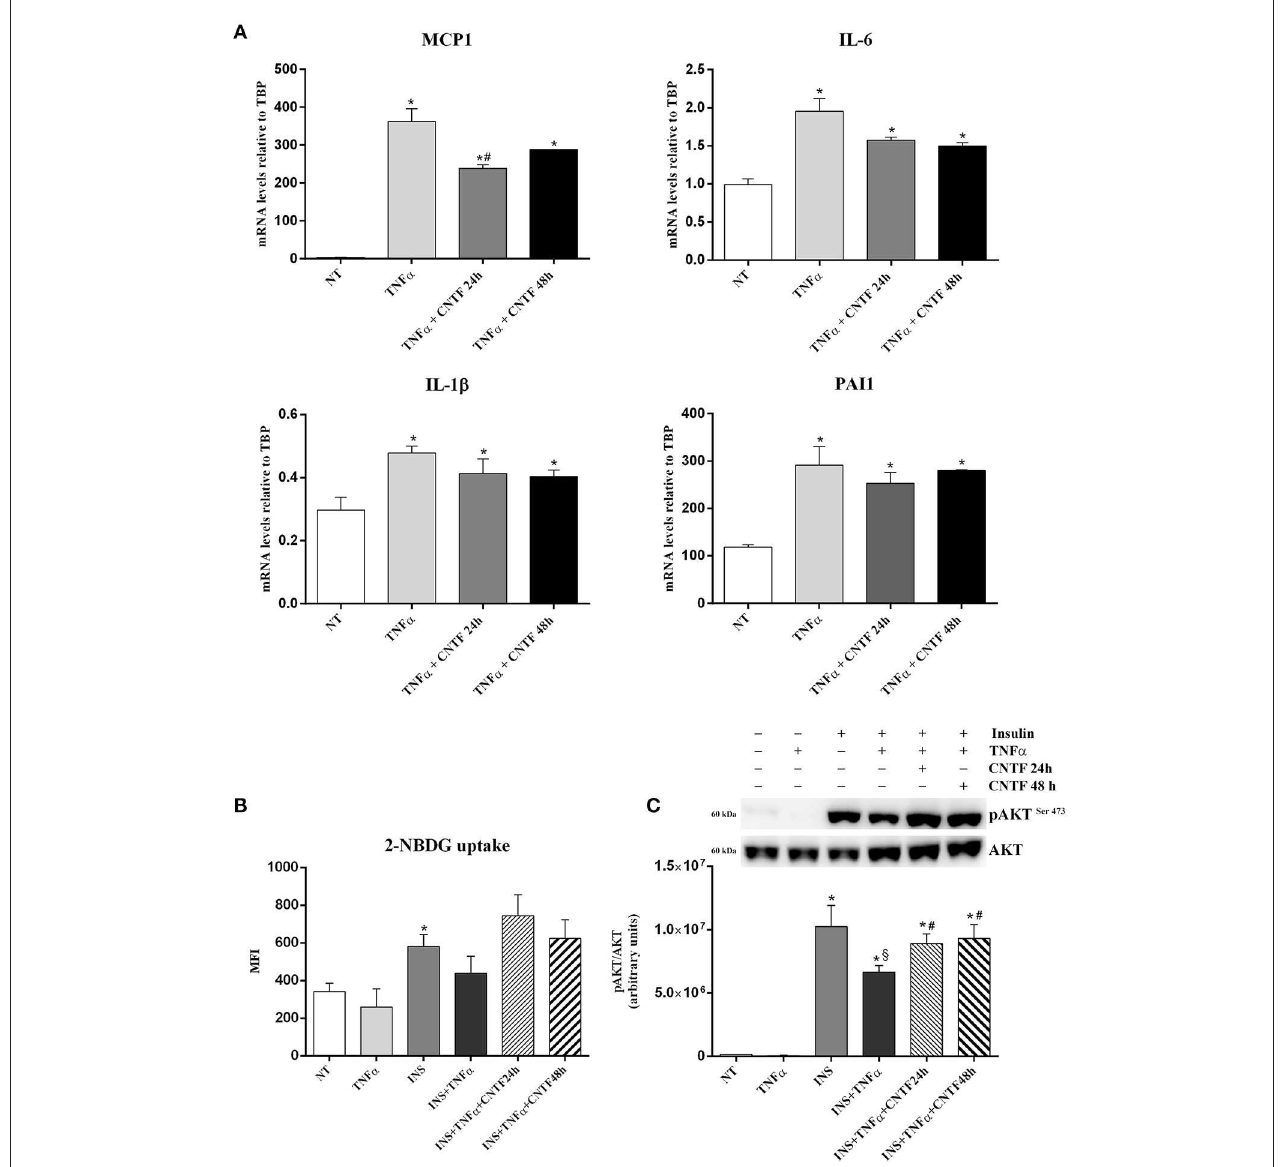
FIGURE 5 | Anti-inflammatory effects of CNTF in hMADS adipocytes. (A) MCP1, IL-6, IL-1 β , and PAI1 mRNA levels in hMADS adipocytes treated for 24h with 10ng/ml TNF α alone or administered with 1nM CNTF for 24 or 48h. Data ( n = 3) are mean ± SEM, * p < 0.05 compared with untreated cells (NT), # p < 0.05 compared with cells treated with TNF α . Data were analyzed using one-way ANOVA. 2-NBDG uptake, expressed as mean fluorescent intensity (MFI), (B) and representative immunoblot and quantification of 473-serine AKT phosphorylation (C) in hMADS adipocytes treated with 10ng/ml TNF α for 24h; with 100nM insulin for 20min; with TNF α and insulin; or with TNF α , insulin and 1nM CNTF for 24 or 48h. Data ( n = 3) are mean ± SEM, * p < 0.05 compared with untreated cells (NT), $ p < 0.05 compared with cells treated with insulin, # p < 0.05 compared with cells treated with insulin and TNF α . Data were analyzed using one-way